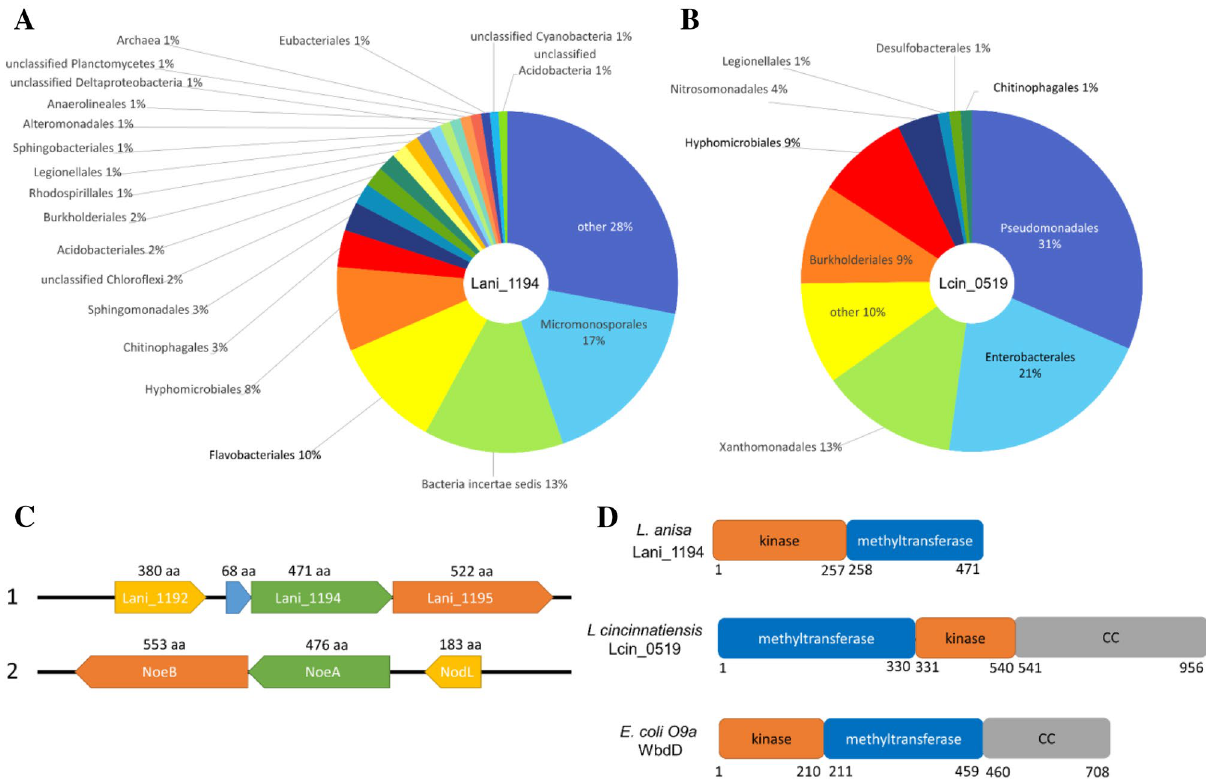
Figure 6. Lani_1194 and Lcin_0519—taxonomic spread, genomic neighborhoods, domain compositions. Organisms with homologs of: ( A ) Lani_1194 and ( B ) Lcin_0519 (found by BLAST search using the kinase domains as queries). Order level shown, or higher if not available. “Others” include taxa containing from 1 to 4 hits (organisms) 28,29 . ( C ) Genomic neighborhood of the protein Lani_1194 (1) and its homolog NoeA (2) in a nodulation-related operon from Sinorhizobium meliloti ; lengths of encoded proteins shown. Coloring reflects homology. ( D ) Arrangement of structural domains of Lani_1194, Lcin_0519 and WbdD proteins. CC denotes the coiled-coil